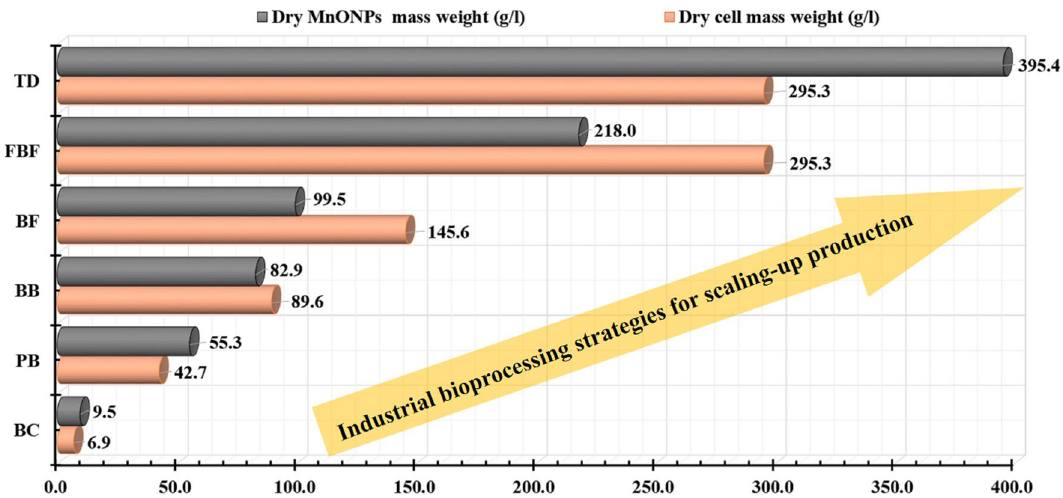
Figure 12. Summary for the bioprocessing strategies that applied for optimizing the endophytic Trichoderma virens strain EG92 mass weight (g/l), as well as the fungus-fabricated MnO NPs mass weight (g/l) using Plackett–Burman (PB), Box–Behnken (BB), and Taguchi (TD) experimental designs. Scaling-up production of fungal mass production via semi-industrial bioreactor (7 L) by submerged fermentation system through batch (BF) fed-batch (FBF) fermentation modes that compared finally to the basal conditions (BC).